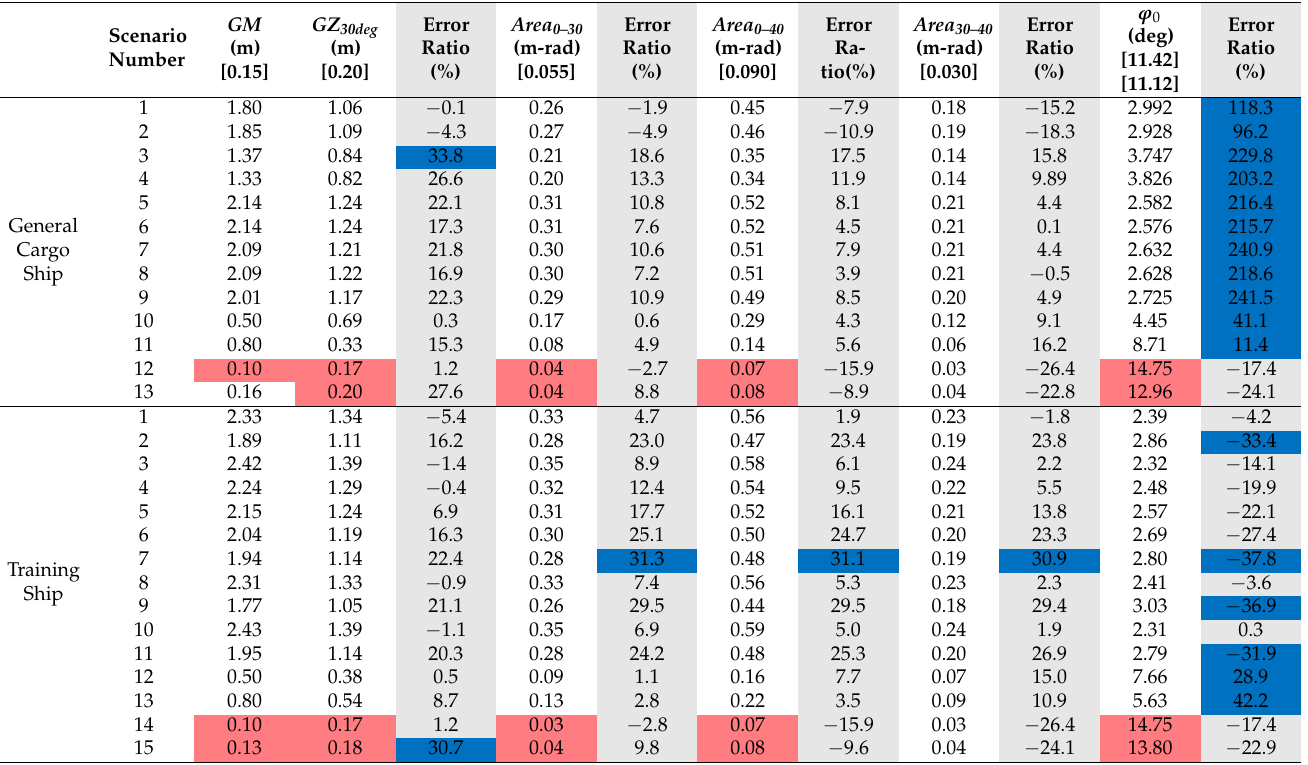
Table 8. Stability calculation using the empirical formulas and error